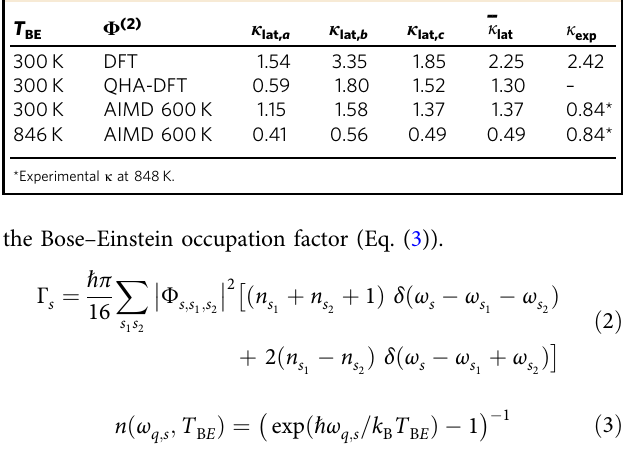
Table 1 Lattice thermal conductivity ( κ lat , Wm − 1 K − 1 ) from BTE with different Φ (2) and Bose – Einstein temperatures ( T BE ) for thermal occupation factor. κ lat, i is along direction i -- κ while is the orientation averaged lat